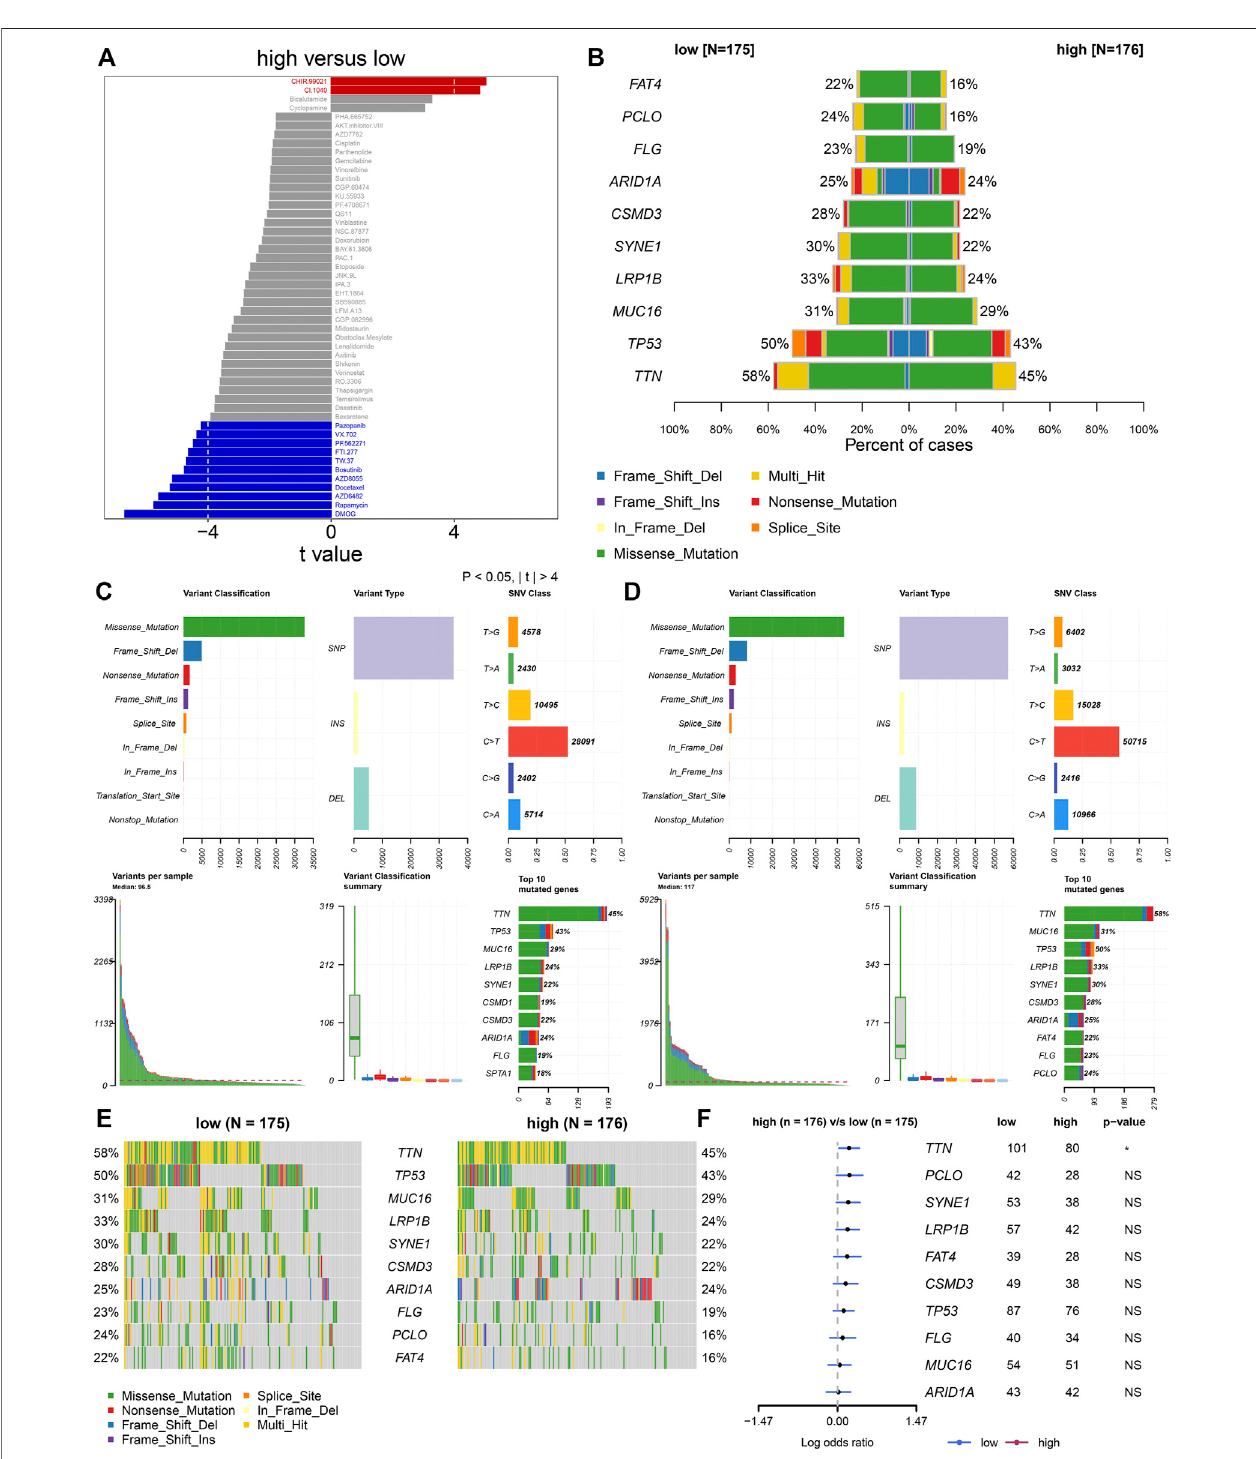
FIGURE6| TNF α -derivedgenomicmodel-relevantdrugresponsesandsomaticmutations. (A) Comparingdrugresponsesbetweenhigh-andlow-riskgroups. (B) Distribution of the fi rst ten mutated genes in high- and low-risk patients. (C,D) Landscape of somatic mutations in high- and low-risk patients. (E) Oncoplots for the fi rst ten frequently mutated genes in two groups. (F) Forest plots showing the differences in mutated genes between groups.